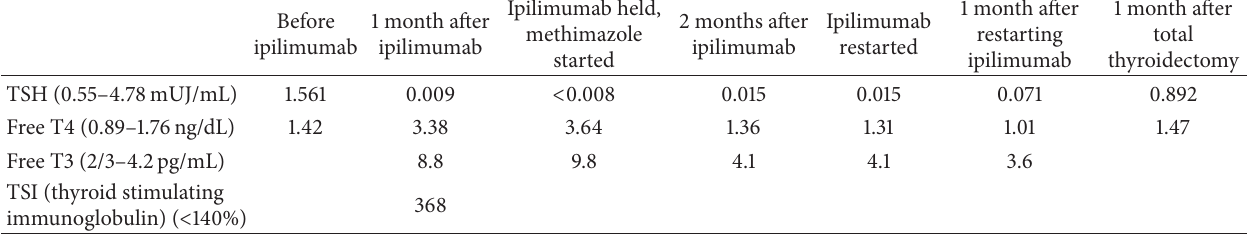
Table 1: Thyroid function tests changes during treatments.